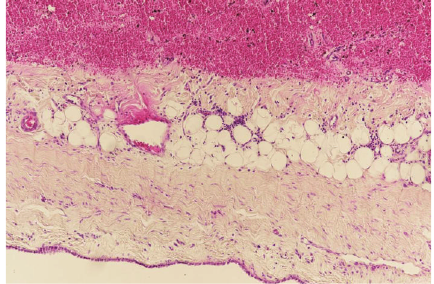
Figure 1: Histopathology ( × 100). Fibrosis and hemorrhage in pleura.